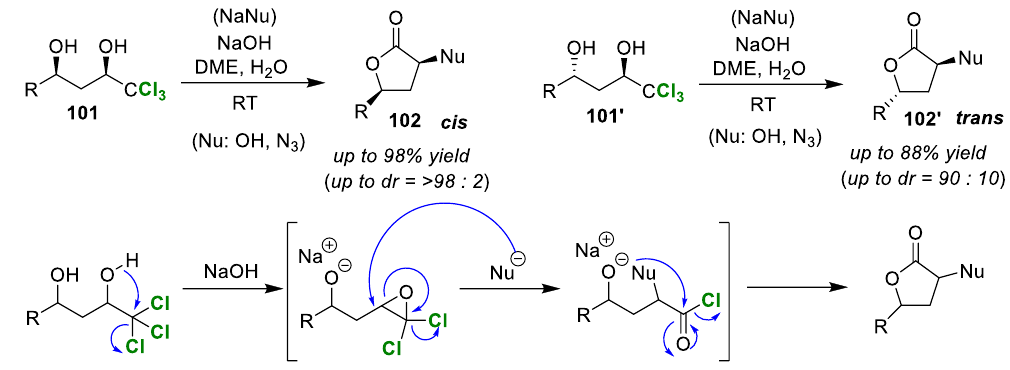
Figure 48. Stereoselective dechlorolactonization reaction of syn-trichlorodiols and anti-trichlorodiols ( 101 and 10 1′ ) under basic conditions.